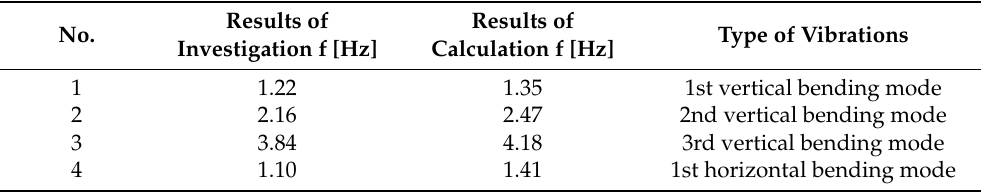
Table 1. Calculated and identified frequencies of the deck’s vibrations.